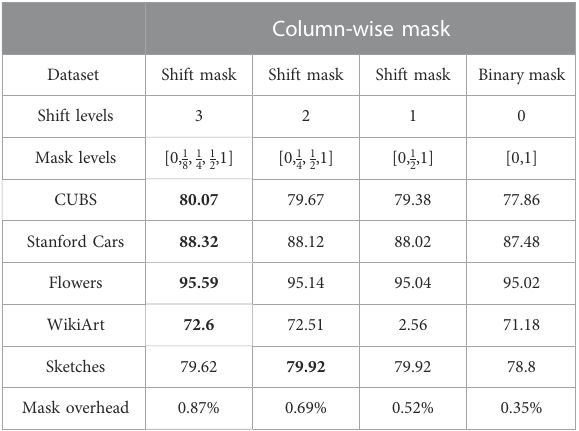
TABLE 2 The impact of different shift